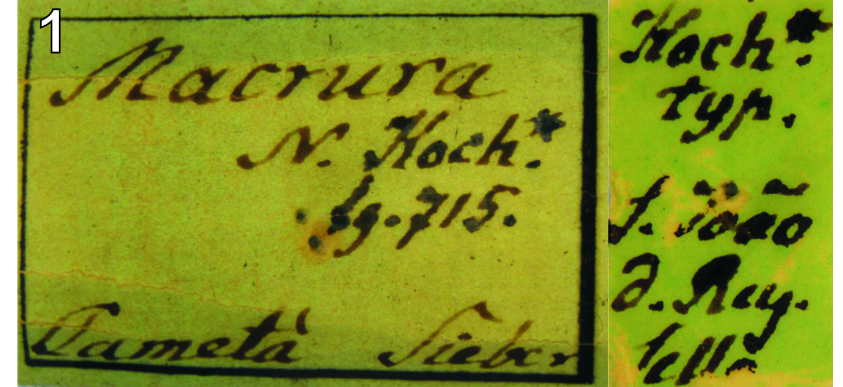
Fig. 1. original (right) and added (left) labels from the holotype of Diplura macrura (C.L. Koch,